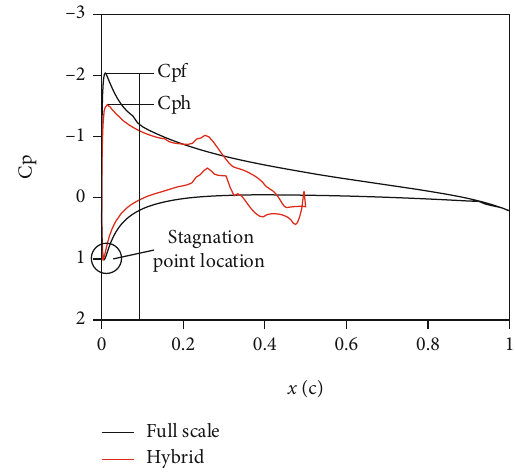
Figure 5: Cp di ff erence of hybrid and full-scale